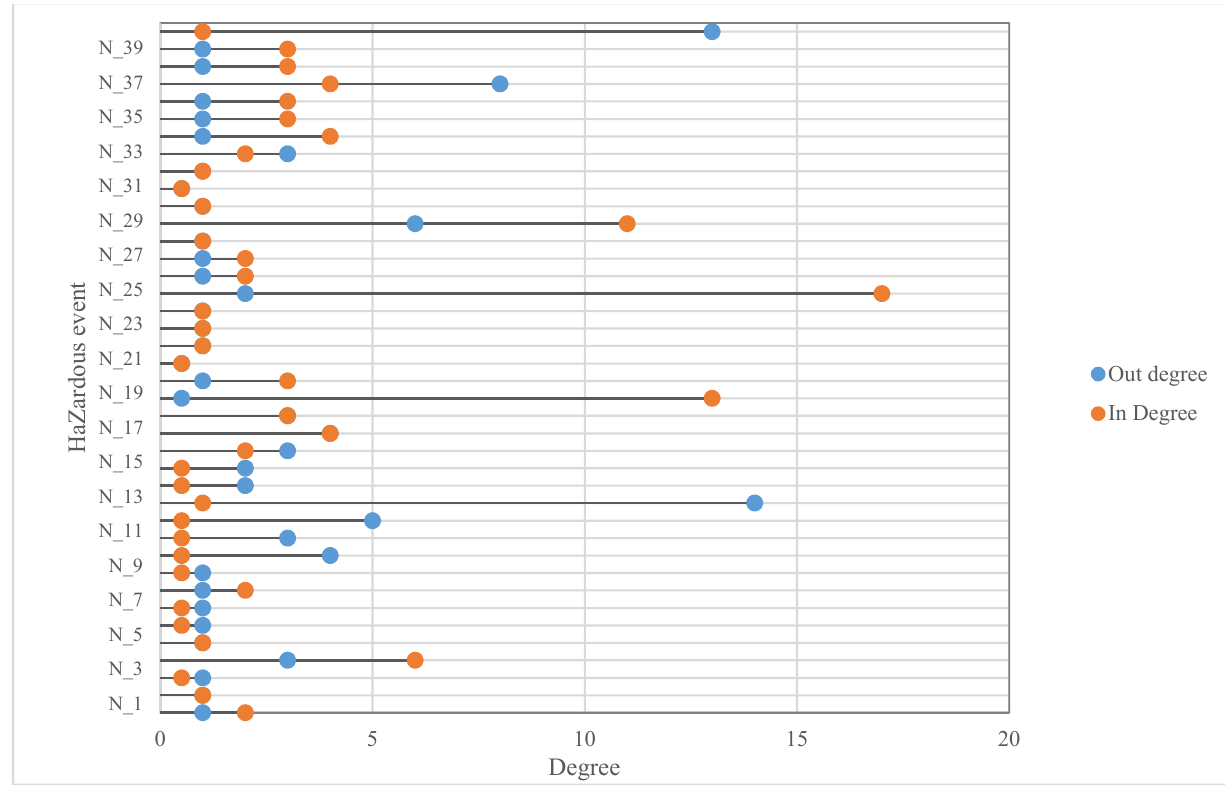
Figure 5. Node evaluation from degree.